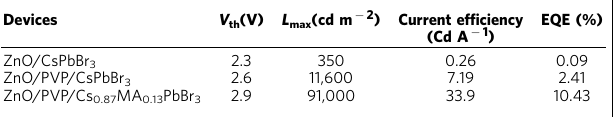
Table 1 | Device performance with and without PVP intermediate layers or CH 3 NH 3 Br (MABr)